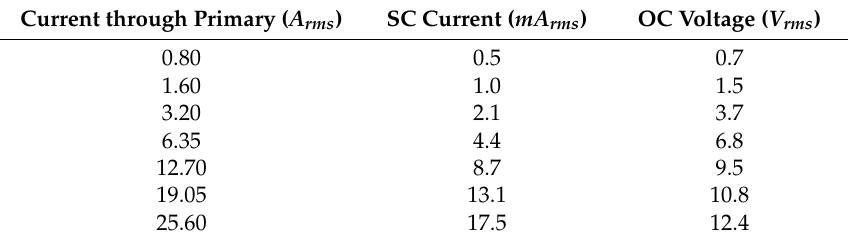
Table 1. Measurement samples on the harvester characterization.